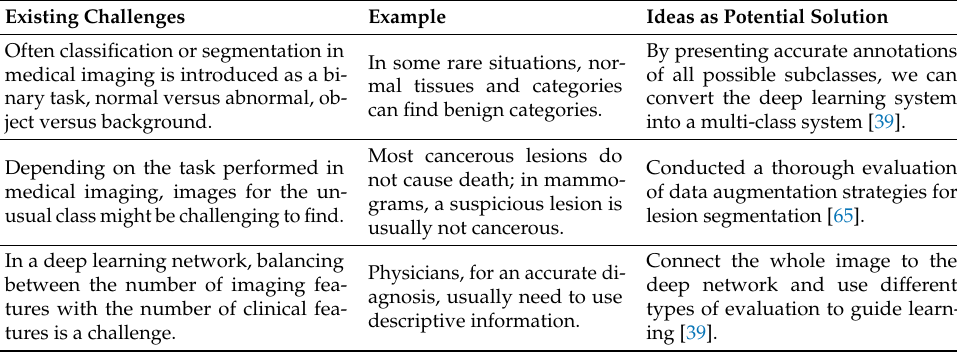
Table 8. Existing challenges and potential